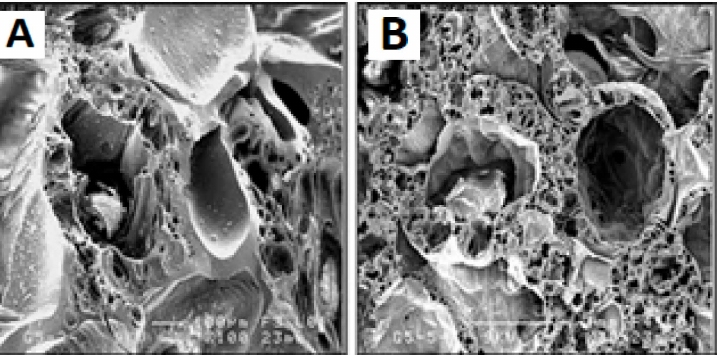
Figure 12. SEM micrographs showing the microstructure of geopolymer material subjected to heat treatment at 250 ◦ C ( A ); at 500 ◦ C ( B ) [110].